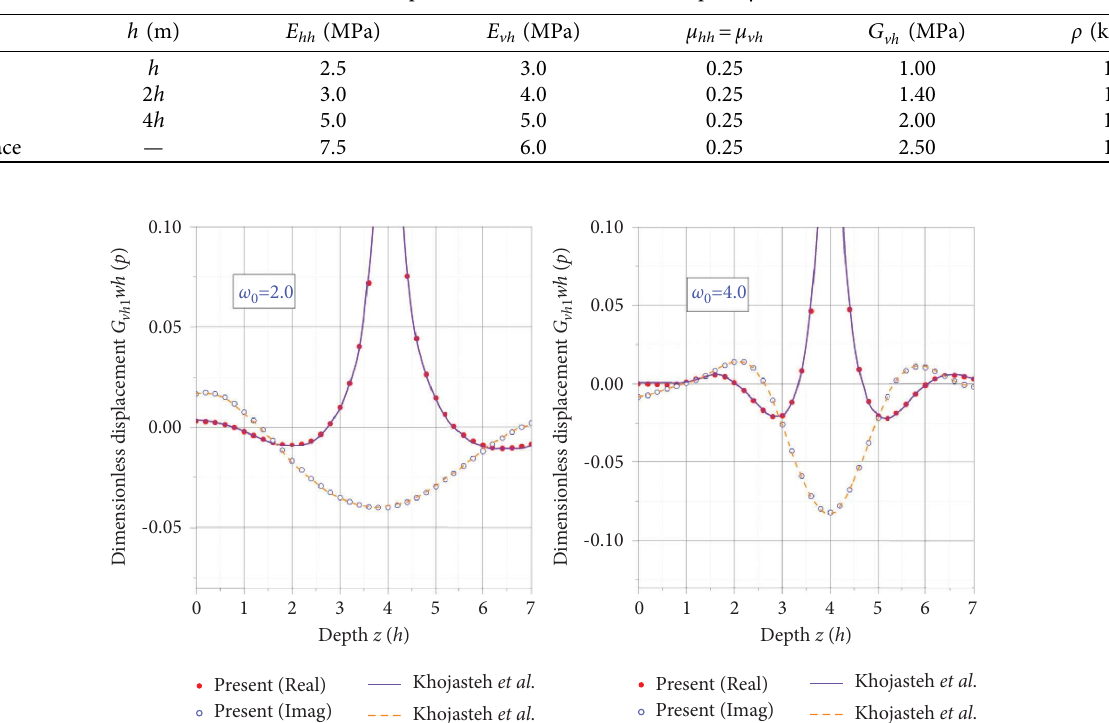
Figure 4: Te real and imaginary parts of the dimensionless vertical displacement at origin versus the dimensionless depth.